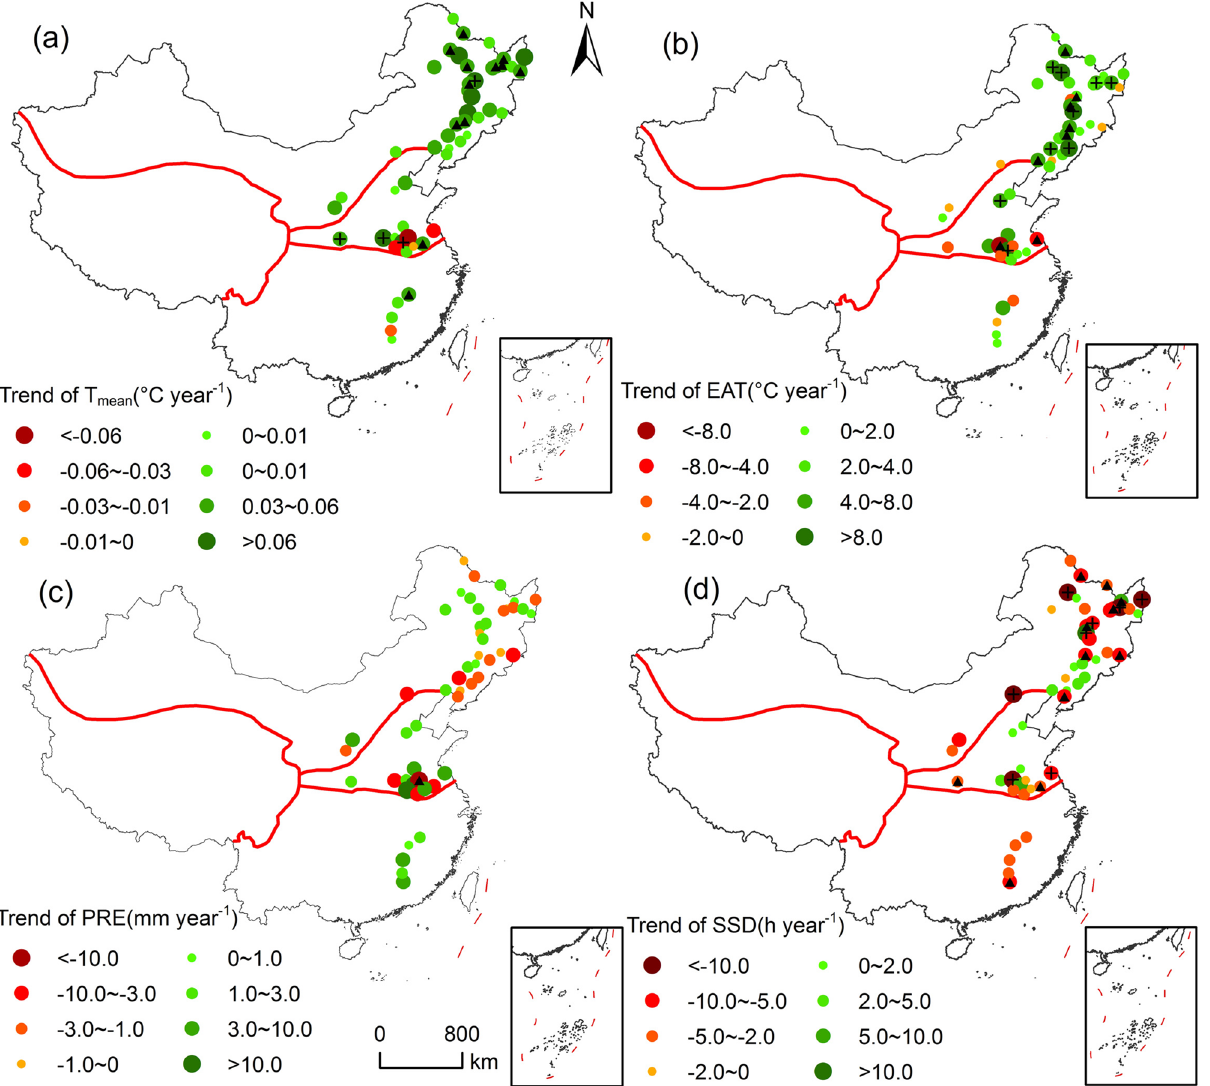
Figure 1. The trend of climatic factors during soybean growing seasons between 1992 and 2018. Abbreviations: ‘ ▲ ’, significant at the 0.05 level; ‘ + ’, significant at the 0.01 level. T mean , EAT, PRE, and SSD represent mean temperature, effective accumulated temperature, cumulative precipitation and sunshine hours, respectively. The map was generated by ArcGIS 10.2 software (https:// www. esri.